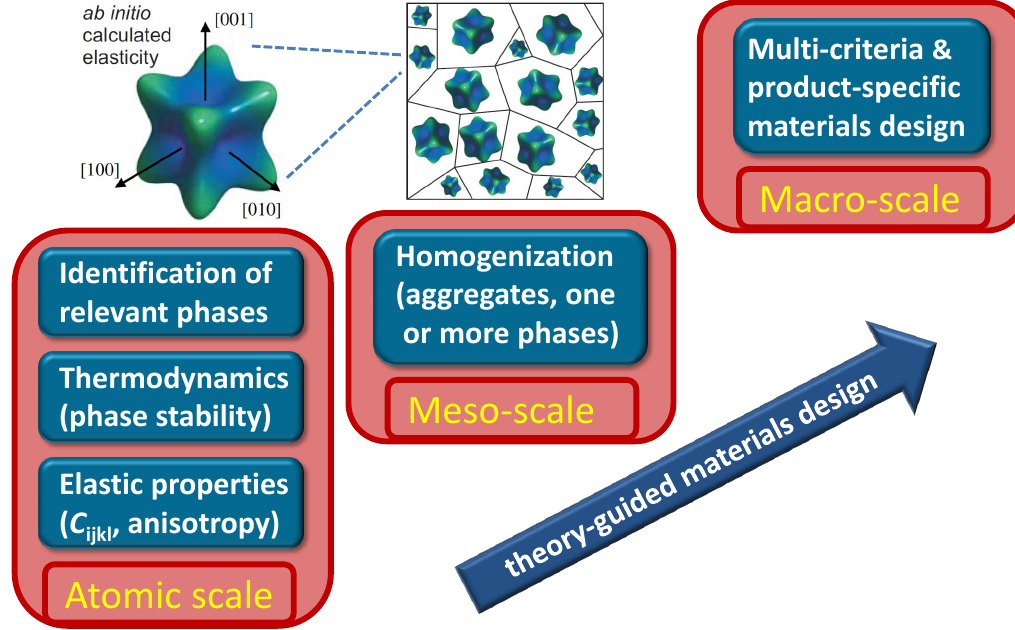
Figure 1. Schematic overview of the multi-scale materials-design strategy combining analy- sis of the thermodynamic phase-stability; and calculation of single-crystalline elasticity data obtained at atomic level by first-principles calculations with self-consistent homogenization techniques in order to bridge scale